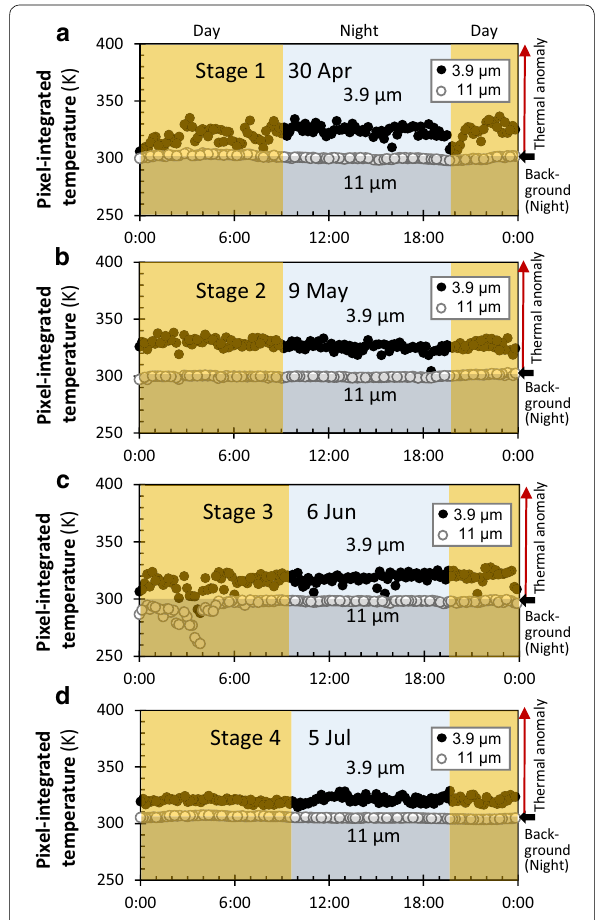
Fig. 4 Short-term variation of maximum pixel-integrated temperature at 3.9 µm (T3.9Mx: closed circles) and 11 µm (T11Mx: open circles) on a 30 April, b 9 May, c 6 June, and d 5